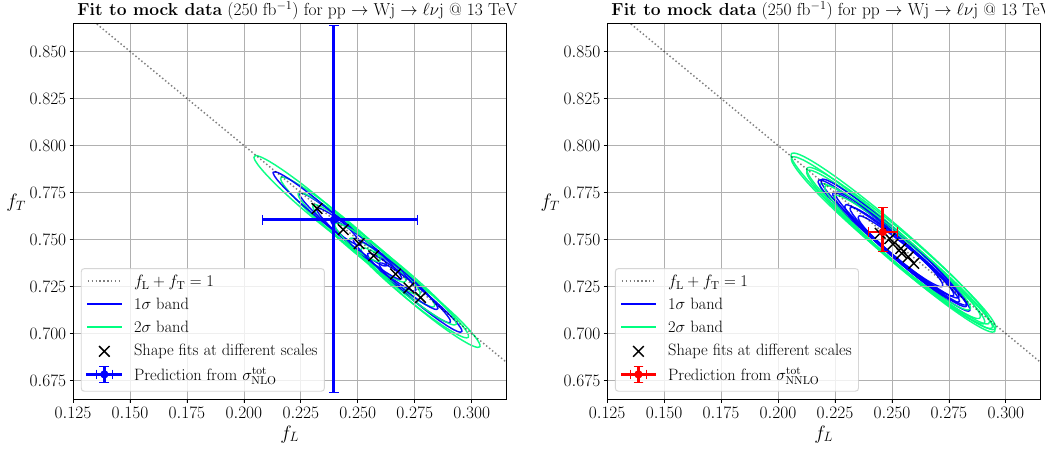
Figure 16 . Fit to the mock data of the polarisation fractions for both signatures of pp → ‘ ± ( − ) ν ‘ j in the fiducial setup using the 2D distribution of rapidity and transverse momentum of the charged lepton at NLO (left) and NNLO (right). Same plot structure as in figure 14.